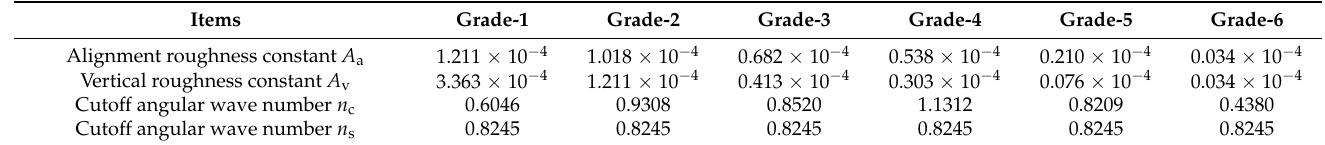
Table 2. Parameters of the PSDs of track irregularities defined in FRA standard.